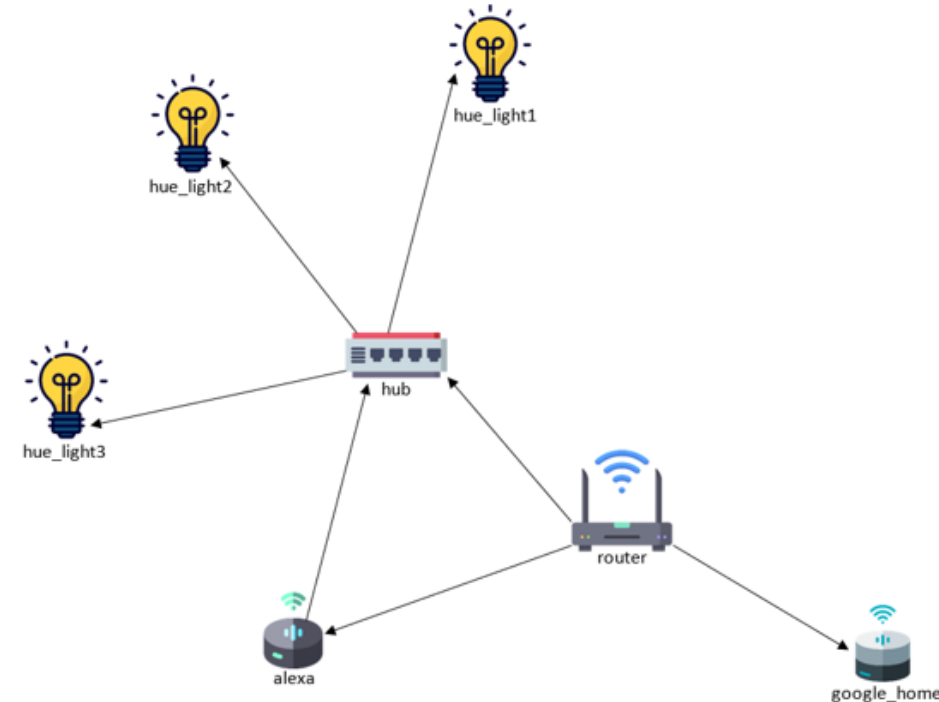
Figure 8. Simulated smart home scenario using Bayesian networks.